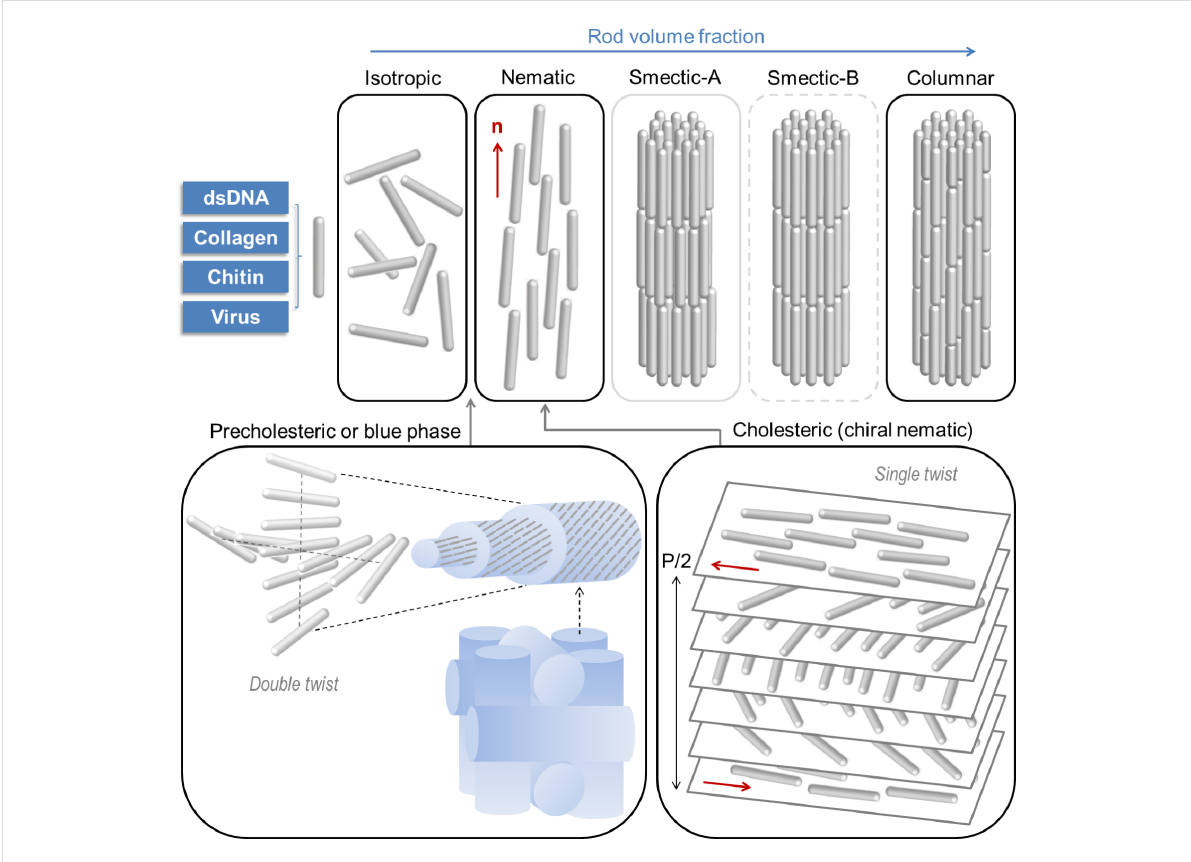
Figure 1: Lyotropic liquid-crystalline phase transition of a dispersion of rod-like particles as a function of rod volume fraction (i.e., rod concentration). A biopolymer (such as dsDNA, collagen, chitin and cellulose) or a filamentous virus (such as fd, M13 and TMV) is represented by a single hard rod. The phase behavior and the path of transitions vary for different types of rods and physicochemical conditions. The mean orientation of rods in nematic phase, called director, is denoted as n . The director undergoes a twist along a single axis (cholesteric phase) or along two axes (precholes- teric or blue phase). In the cholesteric phase, the distance for rotating n by 360° is defined as the helical pitch (P). In the blue phase, a body-centered cubic cell (blue phase I) or a simple cubic cell (blue phase II; depicted in Figure 1) can be formed based on the double-twist cylinders as building blocks. In the smectic phase, the translational symmetry along n is broken without and with positional order, for smectic-A and smectic-B, respective- ly. This lamellar structure is absent in the columnar phase and positional order dominates the system with unidirectionality. Note that, in DNA